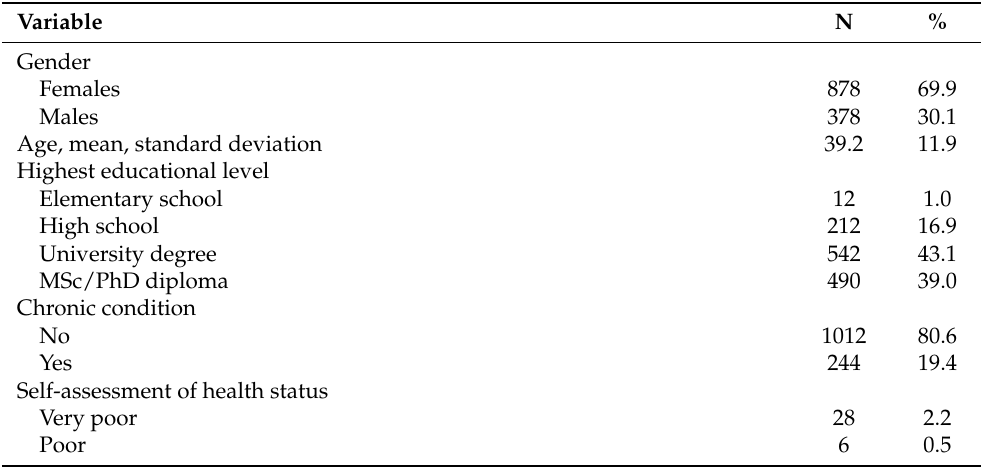
Table 1. Characteristics of the sample (N =